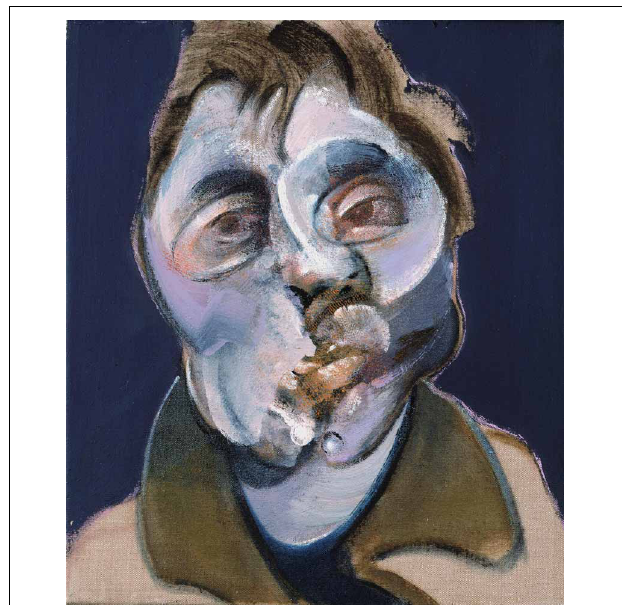
FIGURE 2 | Francis Bacon— Self Portrait, 1969, an example of a mis-aligned face. © The Estate of Francis Bacon. All rights reserved. DACS